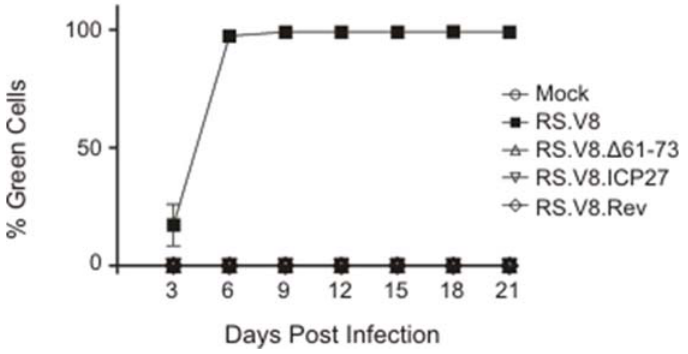
Figure 4. Analysis of infectivity. Virus particles were collected from QT6 cells transfected with wild-type pRS.V8 or mutant proviruses, as indicated. Particles were normalized and then used to infect naive DF1 cells. Infected cells were passaged and examined every 3 days post-infection to detect expression of GFP from integrated proviruses using flow cytometry. The percentage of GFP-expressing cells at each time point was plotted. Neither the deletion mutant ( ∆ 61-73) nor either of the substitution mutant viruses were infectious. The graph shown is the average of three independent infection assays with error bars showing standard error of the mean.